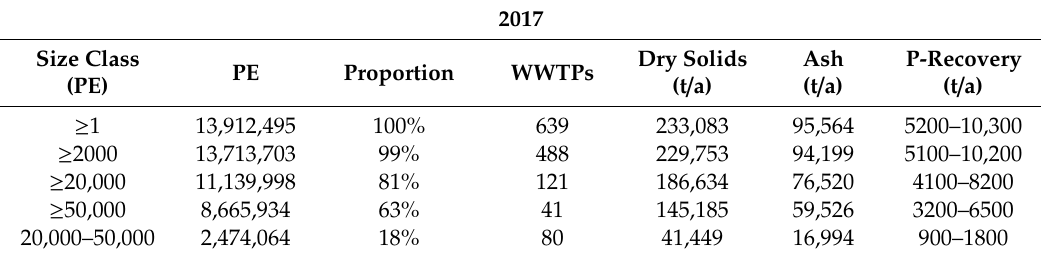
Table 12. The amount of population equivalent (PE), WWTPs, and yearly dry solids production is given for size classes from 1 to 50,000 PE. The amount of produced sludge is given in proportion to each size class. The yearly ash produced by mono-incineration and correlation P-recovery